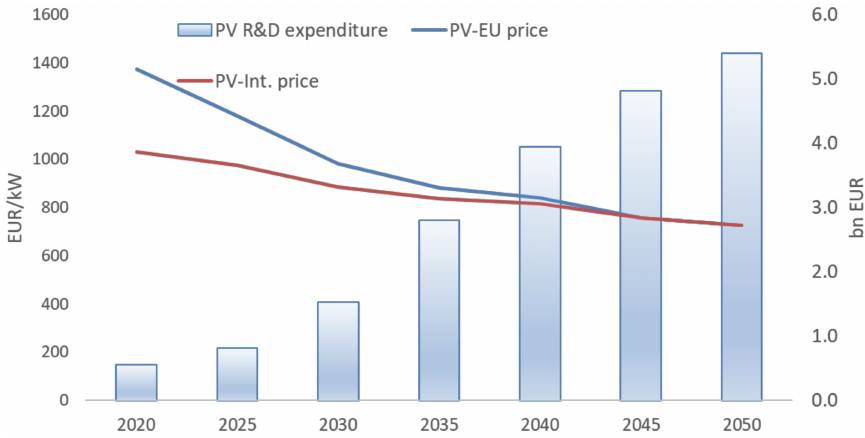
Figure 8. EU R&D expenditure in PV (bn EUR) and development of PV costs (EUR /